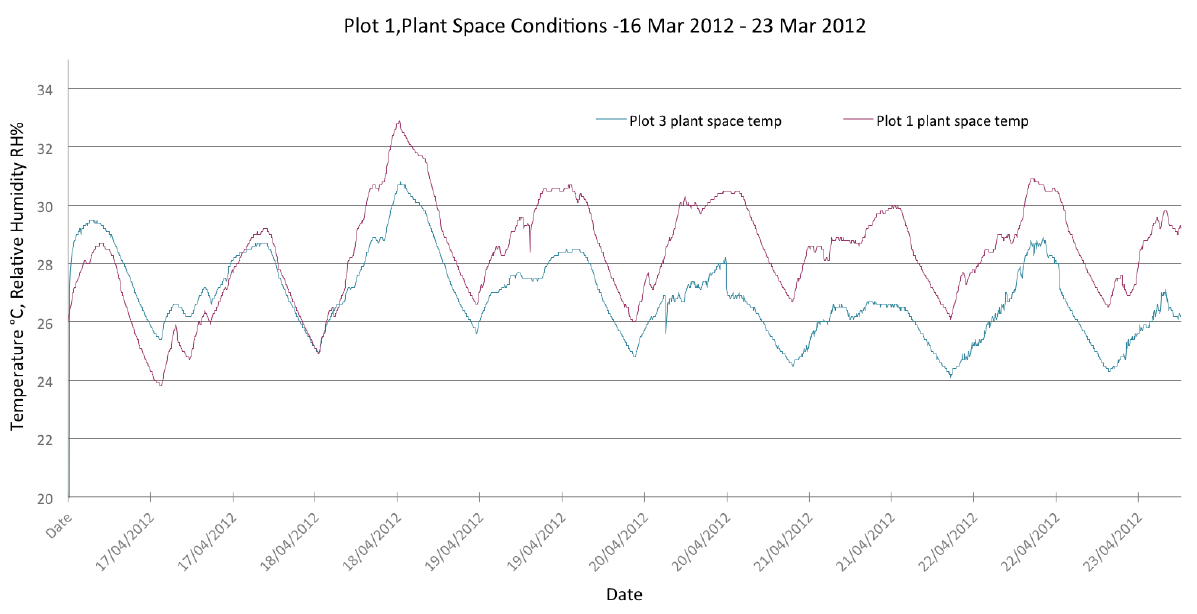
Figure 14. SC3 plant space temperatures Plots 1 and 2.